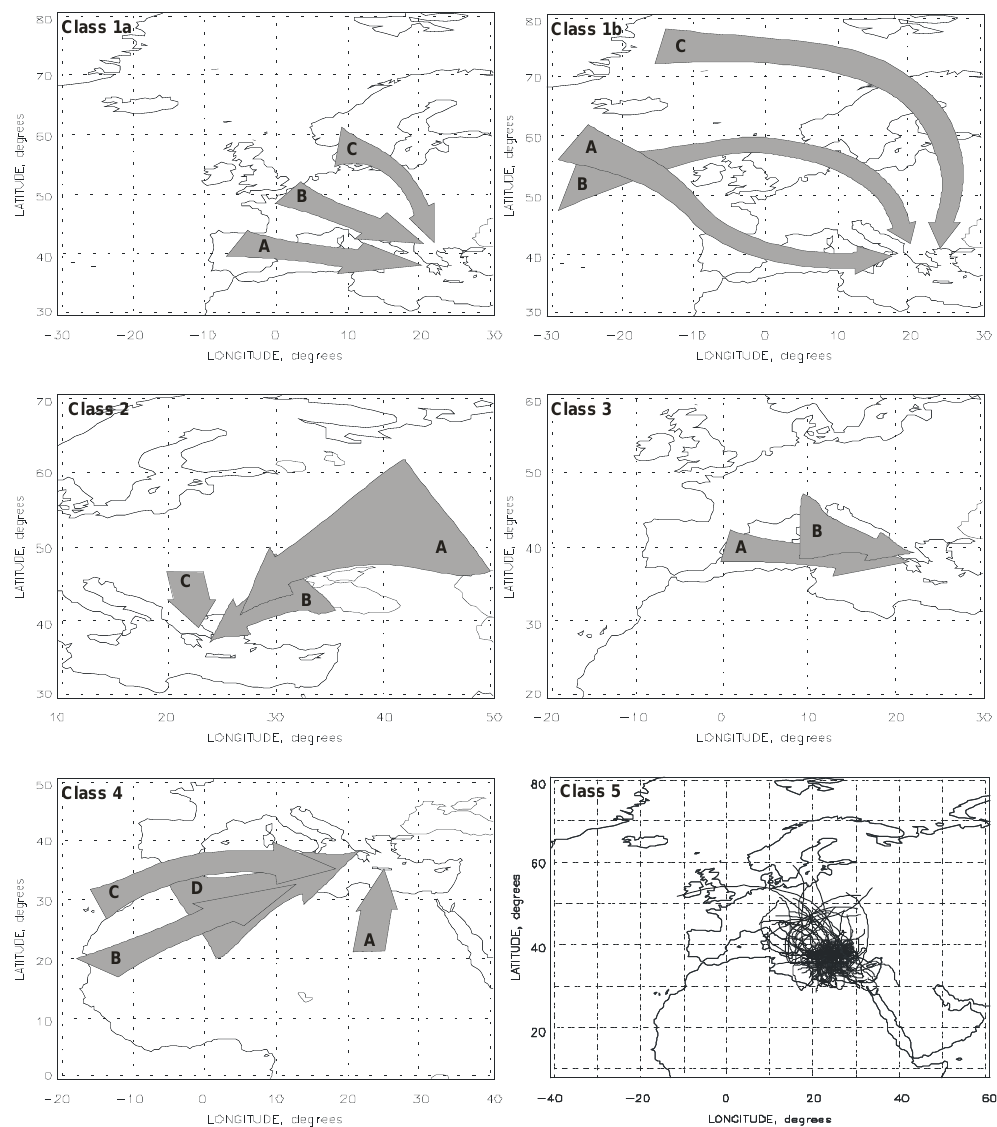
Fig. 6. Cluster analysis of HYSPLIT trajectories for the period 2006–2008. 16 distinct synoptic set ups were grouped into 5 main classes by means of sectoral direction. Arrows follow the direction of the cluster centroid; where feasible, the width of the arrow is representative of the scatter of the trajectories around the calculated Figure 6. Cluster analysis of HYSPLIT trajectories for the period 2006-2008. 16